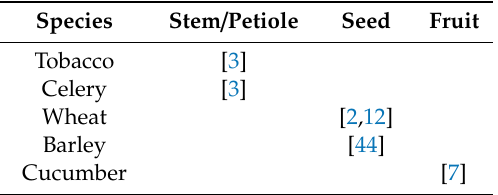
Table 2. Examples of evidence for C4 pathways in non-leaf tissues of C3